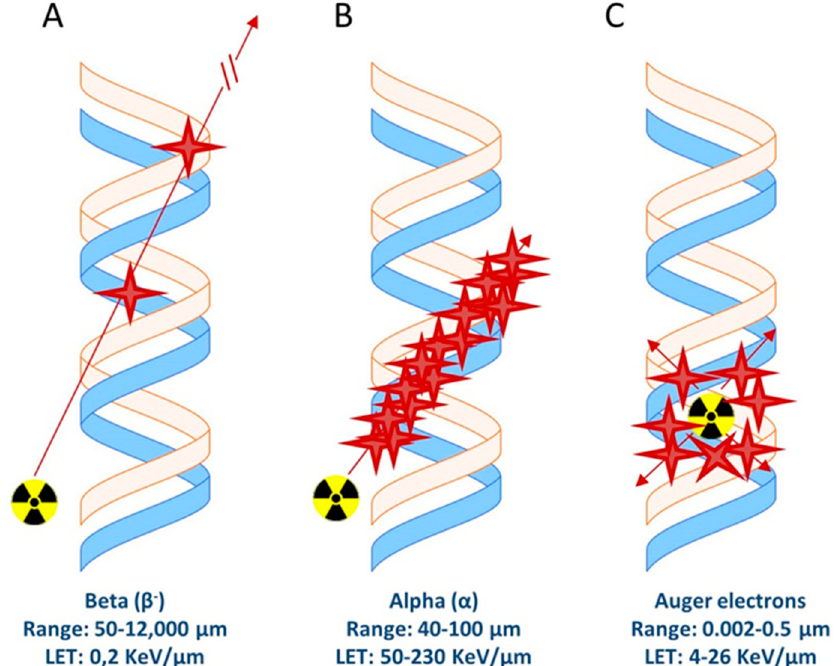
Figure 2. Schematic representation of ionization events caused by ( A ) beta particles, ( B ) alpha particles, and ( C ) Auger electrons.